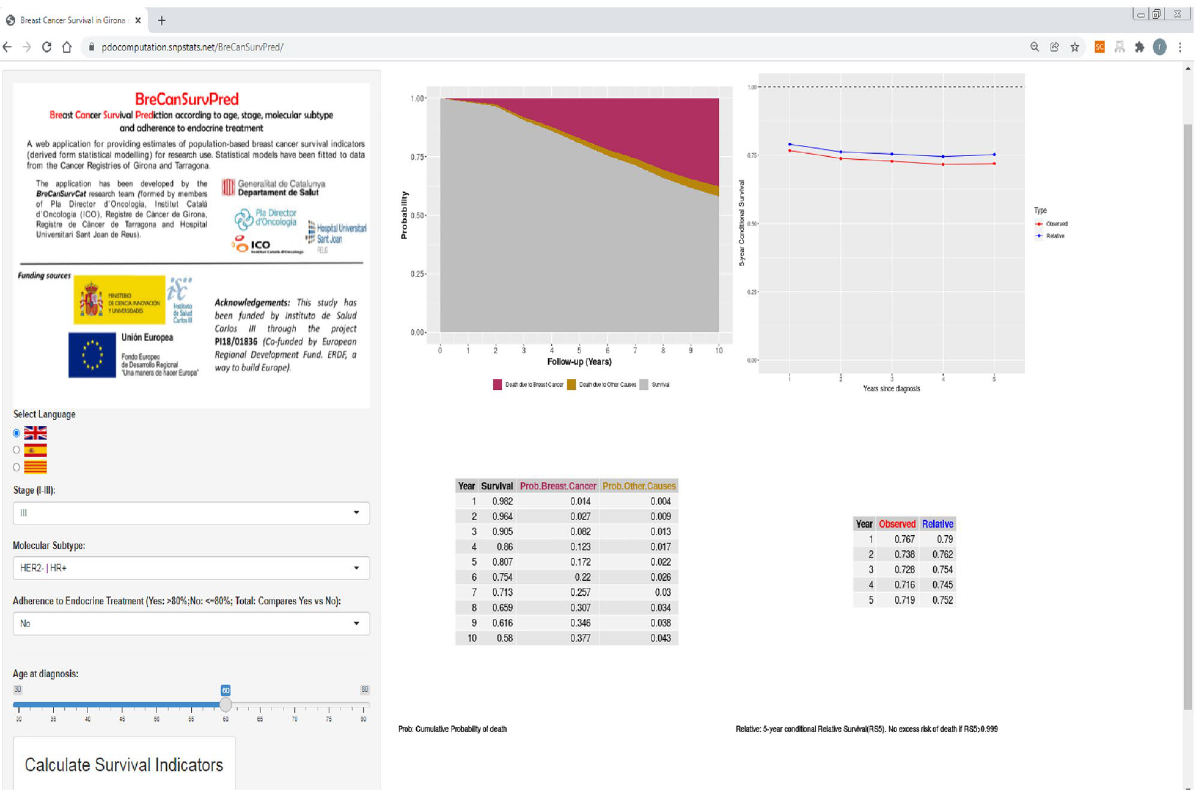
Figure 4. Snapshot of the web-based survival prediction application BreCanSurvPred. This snapshot demonstrates the probabilities of survival and death as well as the 5-year conditional probabilities of observed survival and relative survival for a 60-year old patient who was not adherent to endocrine therapy and who was diagnosed with stage III molecular subtype HER2 − /HR + breast cancer. These probabilites are calculated up to 10 years after BC